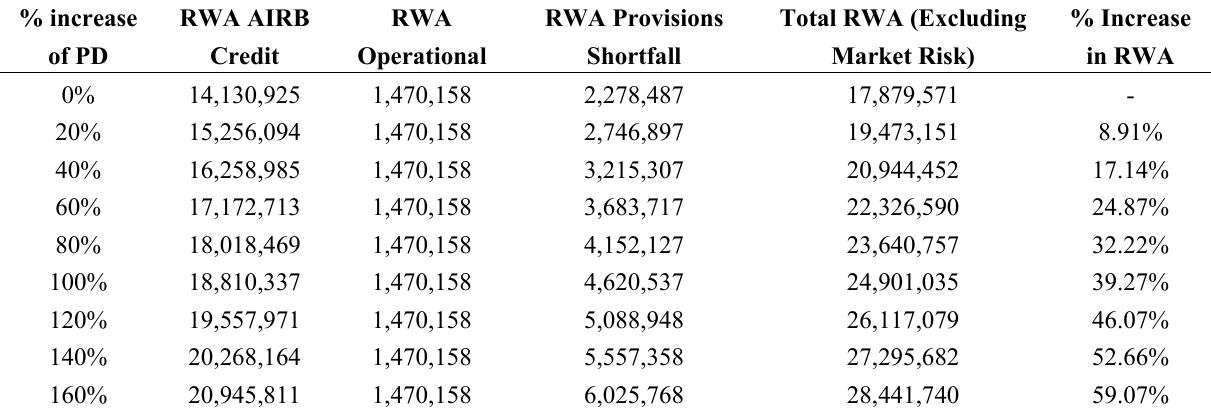
Table 7. Bank 3: stress scenarios for different levels of PD increases (th.